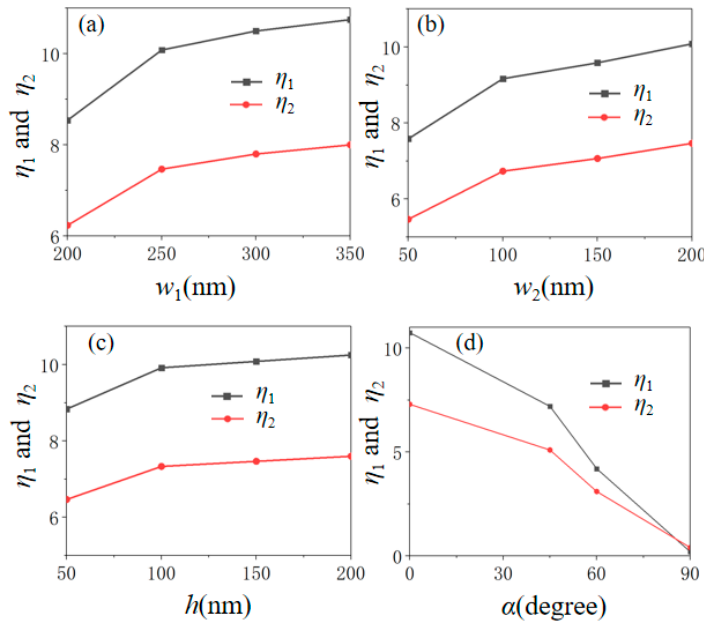
Figure 4. The enhancement factors η 1 and η 2 versus ( a ) w 1 , ( b ) w 2 , ( c ) h , and ( d ) α